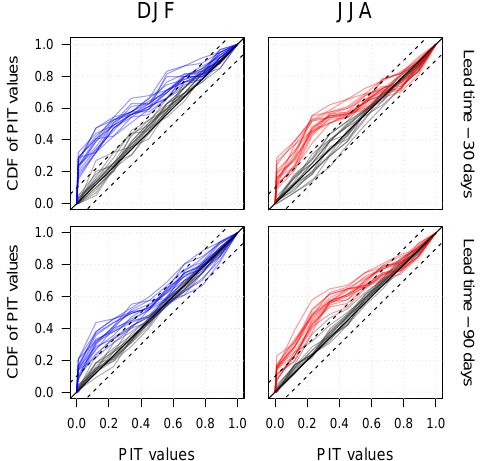
Figure 4. Skill of weekly streamflow forecasts from raw precipi- tation forecasts as a function of the lead time for all catchments and for the winter (DJF) and summer (JJA) seasons. The skill is computed based on the IQR (top) and the CRPS (bottom) and the reference is ESP. Each column corresponds to a target season. Each line represents the skill score in a catchment for forecast horizons within the target season.